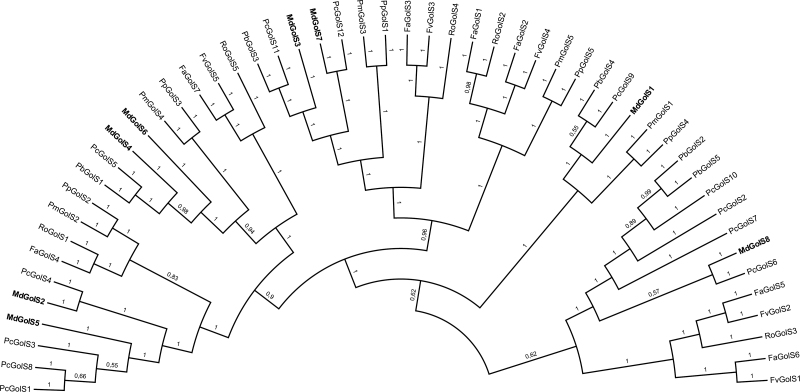
Phylogenetic relationships of GolS protein sequences from eight Rosaceous species. The tree was inferred using MrBayes version 3.2.6 (Ronquist et al., 2012). Branch support is given by a posteriori probability value shown next to the corresponding branches (when >0.5). Accession codes used in the phylogenetic analysis are depicted in Table S3. Fa, Fragaria × ananassa; Fv, Fragaria vesca; Md, Malus × domestica; Pb, Pyrus bretschneideri; Pc, Pyrus communis; Pm, Prunus mume; Pp, Prunus persica; Ro, Rubus occidentalis.